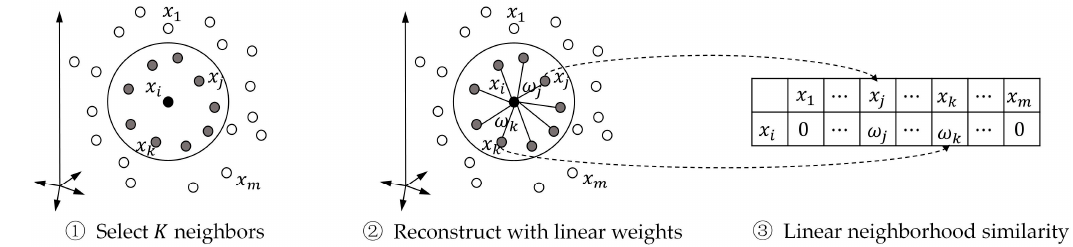
Figure 3. Procedure of calculating linear neighborhood similarity.